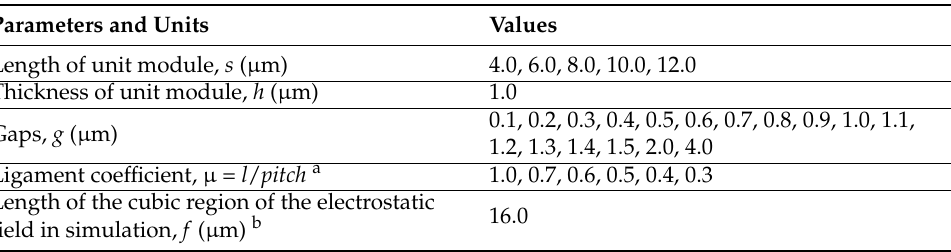
Table 1. Parameters of